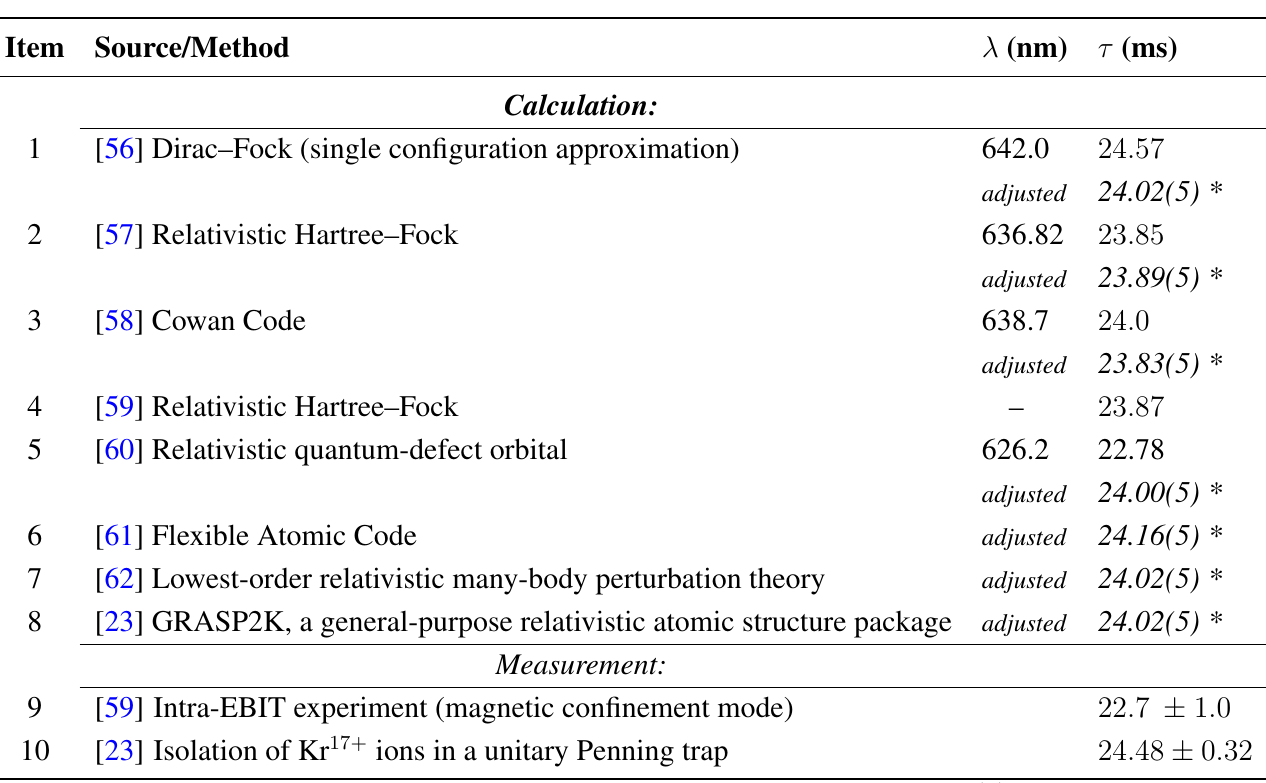
Table 1. Calculations and measurements for the lifetime τ of the Kr 17+ 3d 2 D from Table 1 in